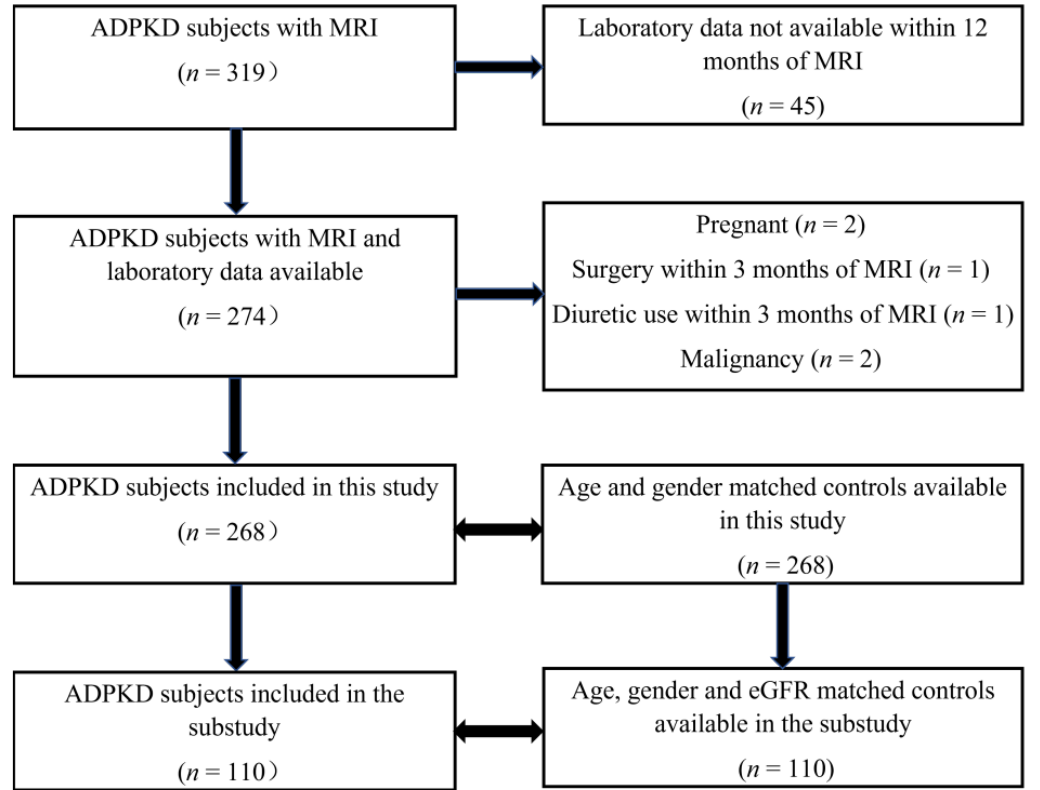
Figure 2. Patient flow chart. The “sub-study” corresponds to the cohort controlling for renal function (eGFR by CKD stage) in addition to age and gender.